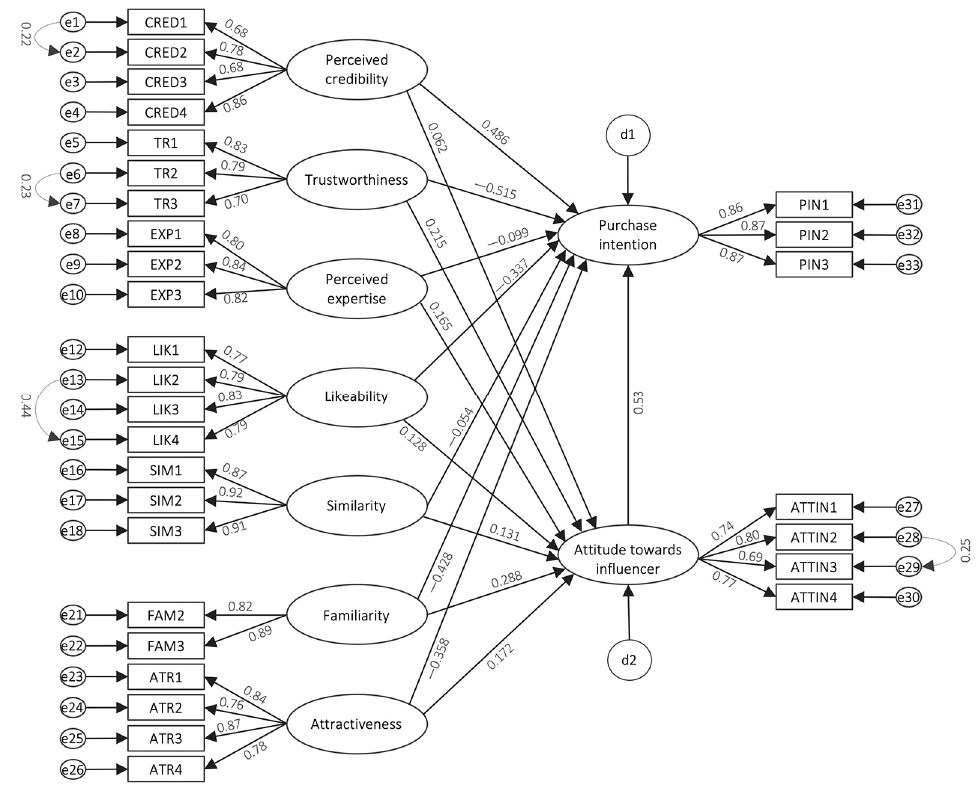
Figure 2. Path modelling of independent variables and purchase